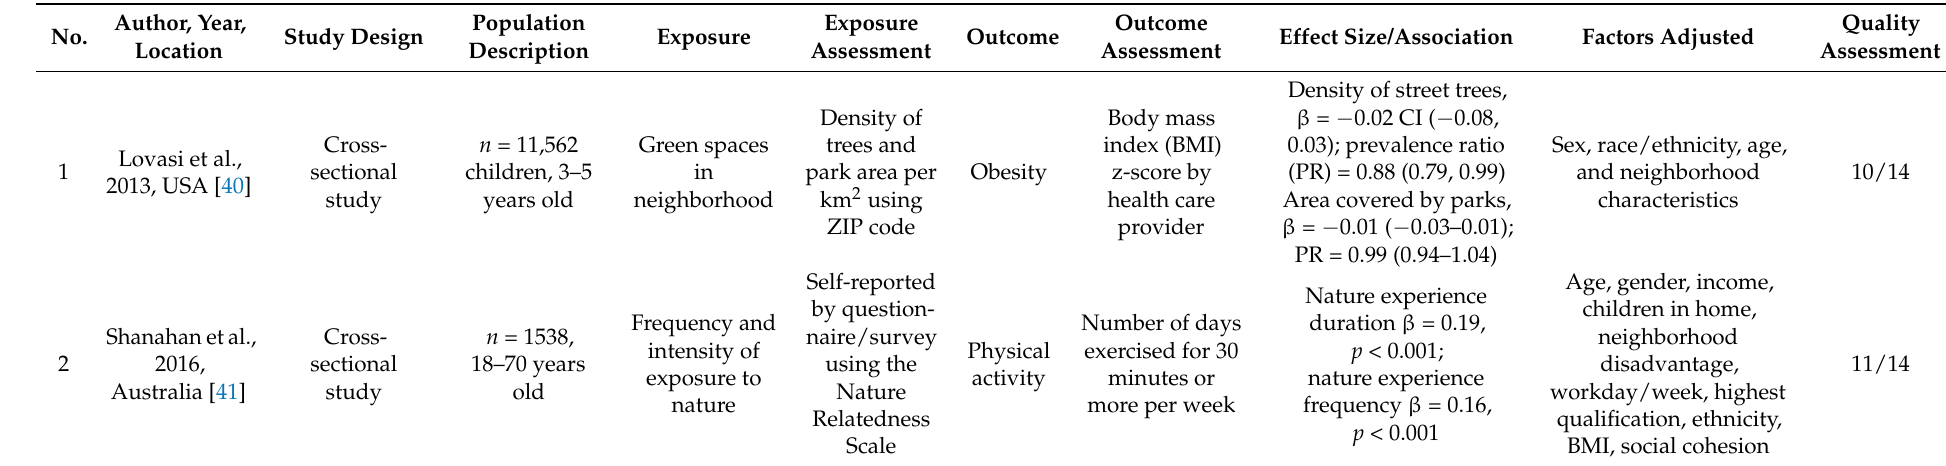
Table 2. Characteristics of included studies. Secondary outcomes: obesity, overweight, and physical